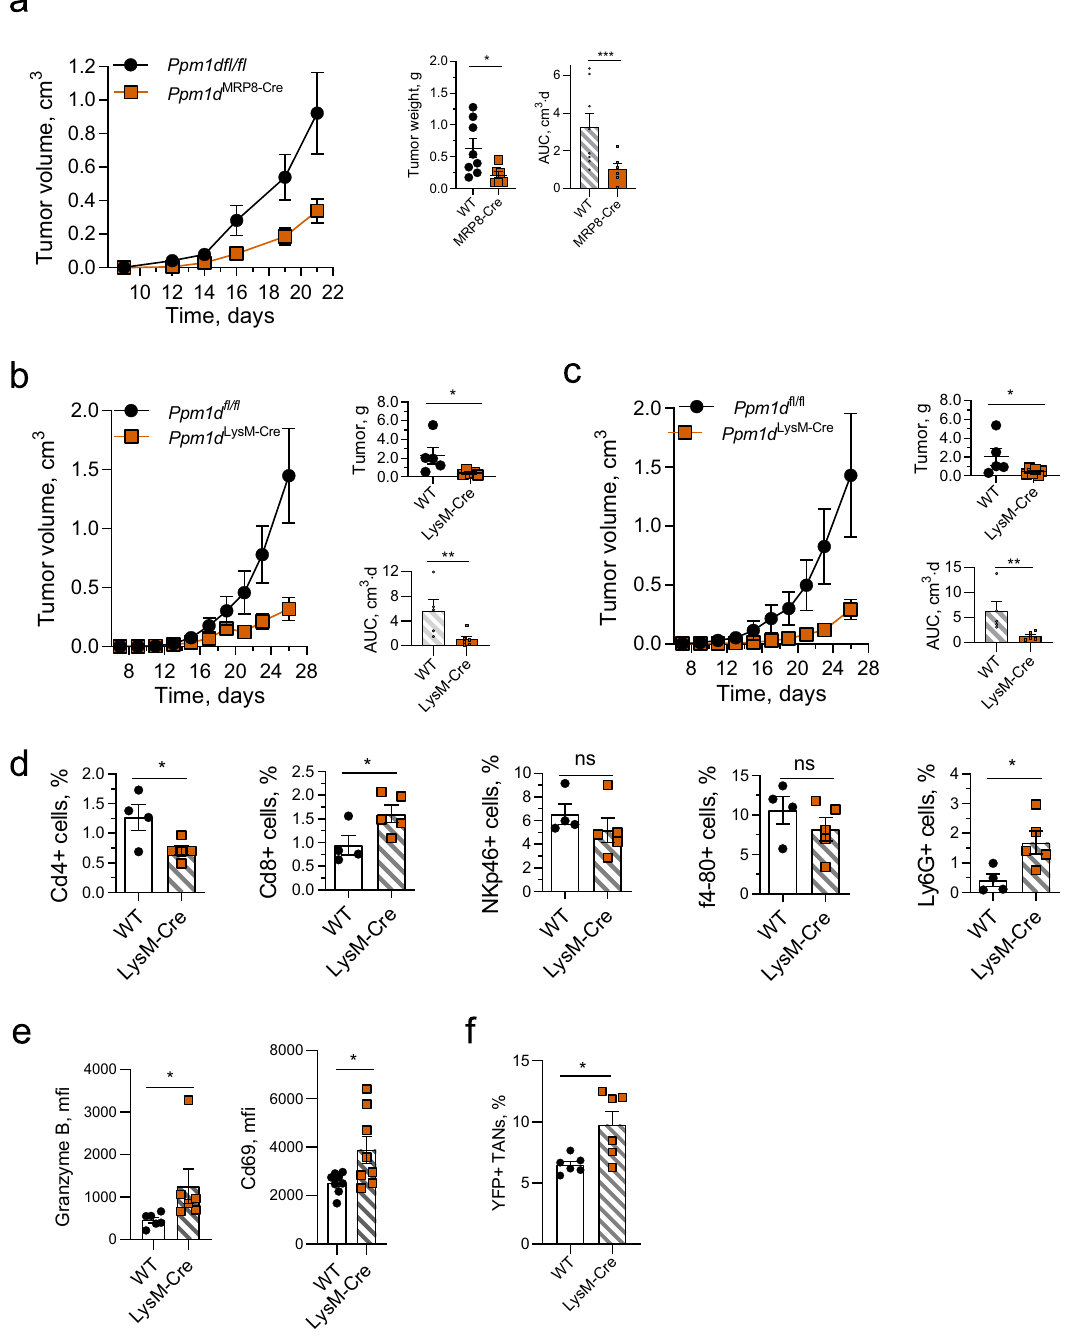
Fig. 4 Wip1 de fi ciency in myeloid immune cells suppresses the growth of solid tumors. a Tumor volume (left), endpoint tumor weights (center), and AUC (right) for growth of B16 F10 tumors in Ppm1d fl / fl ( n = 8) and Ppm1d MRP8-CRE ( n = 6) mice. b Tumor volume (left), endpoint tumor weights (upper right), and tumor growth area under the curve (AUC) (lower right) for growth of B16 F10 melanoma tumors in Ppm1d fl / fl ( n = 5) and Ppm1d LysM-Cre ( n = 6) mice. c Tumor volume (left), endpoint tumor weights (upper right), and AUC (lower right) for growth of LLC1 lung carcinoma tumors in Ppm1d fl / fl ( n = 5) and Ppm1d LysM-Cre mice ( n = 6). d In fi ltration by immune cell subsets into LLC1 tumors engrafted in Ppm1d fl / fl (WT, n = 4) and Ppm1d LysM-Cre (LysM-Cre, n = 5) mice. e Expression of activation markers in CD8 + T cells in fi ltrated in B16 F10 tumors in Ppm1d fl / fl (WT) and Ppm1d LysM-Cre (LysM-Cre) mice on day 16 (Granzyme B — n = 6, Cd69 — n = 8 each genotype). f In fi ltration of B16 F10 tumors by YFP + WT LysM-cre or YFP + Ppm1d LysM-cre neutrophils after their adoptive transfer in wild-type tumor-bearing mice ( n = 6 for each genotype). Data are depicted as means ± SEM. Student ’ s t test (two-tailed) (panels d , e and panels a , b , c : tumor weights) or Mann – Whitney test (two-tailed) (panels a , b , e : AUC, and panel f ): * p < 0.05; ** p < 0.01; *** p < 0.001 (one representative experiment out of 3 is shown for panel a , b and one out of 2 is shown for panel f ). Source data are provided as a Source Excel Data fi